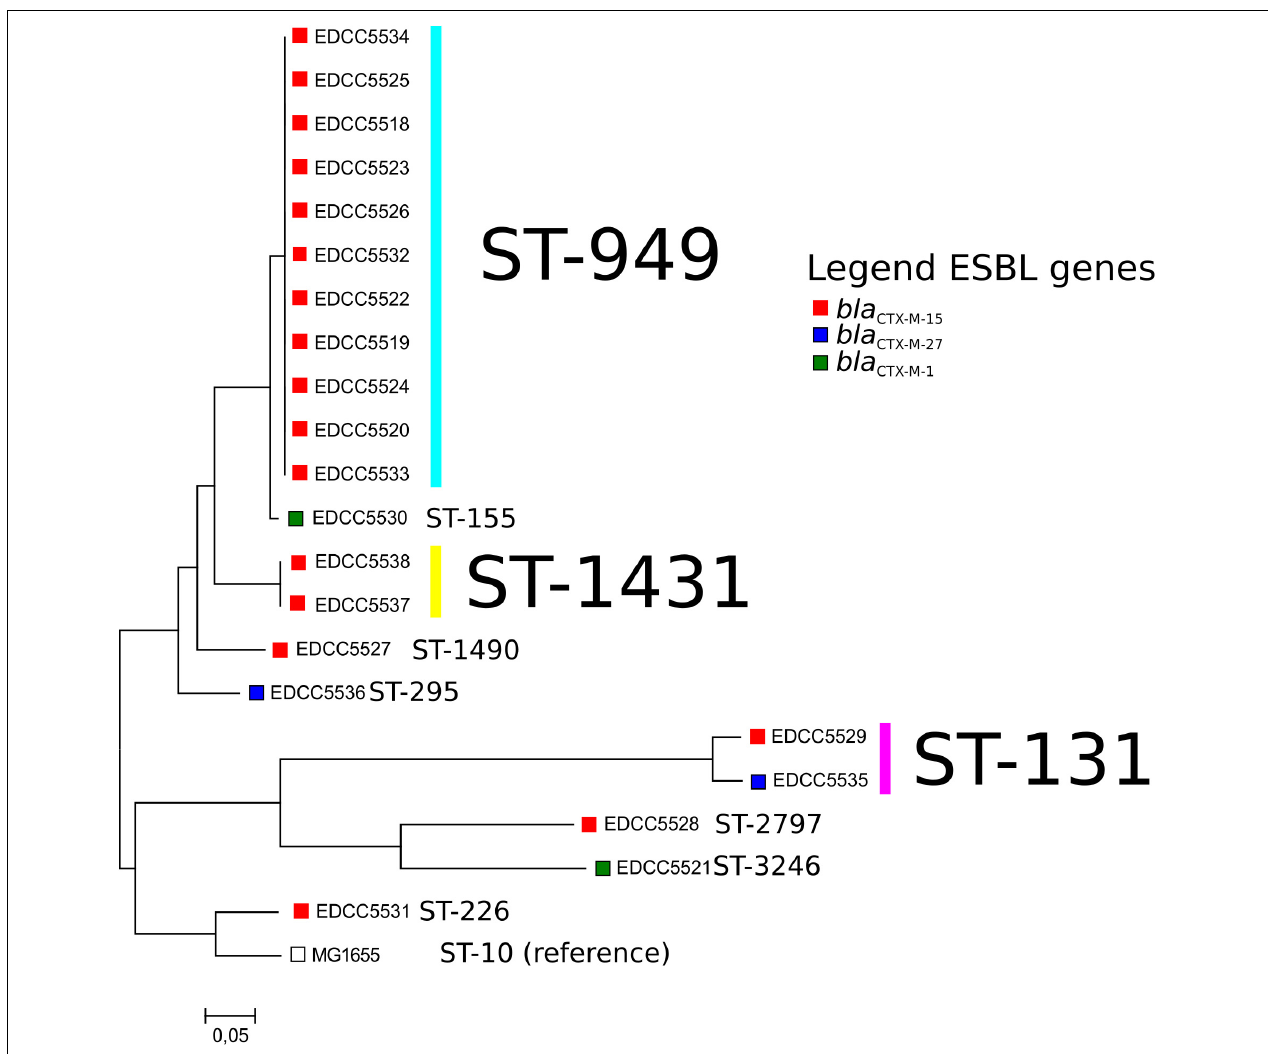
FIGURE 2 | Core-genome-based comparison of the E. coli isolates analyzed in this study. Boxes depict the ESBL gene present in these isolates. For a representation of the isolate geographical location and the phylogeny, please see the following link: